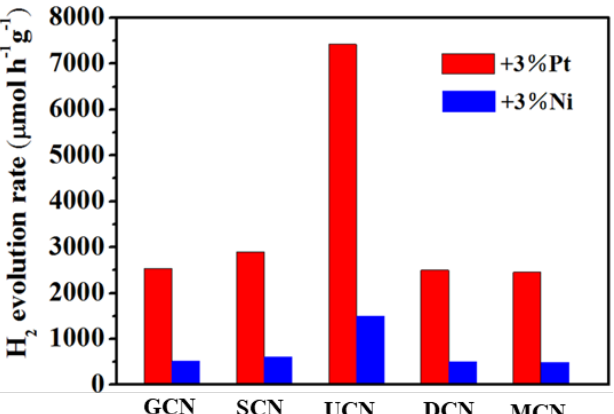
Figure 3. Photocatalytic H 2 evolution on the MCN, DCN, GCN, SCN and UCN samples with the Pt or Ni as the co − catalyst.